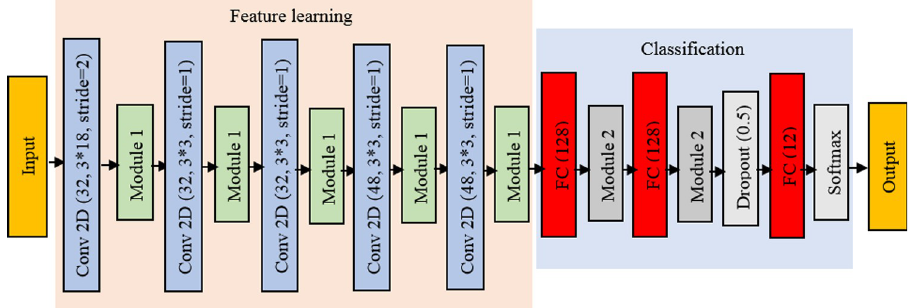
Fig 3. Classifier architecture. Module 1 consists of the following layers: Batch normalization + ELU + Maxpooling 2 � 2. Module 2 consists of the following layers: Batch normalization + ELU. Conv2D (32, 3 � 18) is a 2-dimensional convolution layer with a kernel size of 3 � 18 and the number of filters is 32. FC (128) is a fully connected layer with 128 neurons.